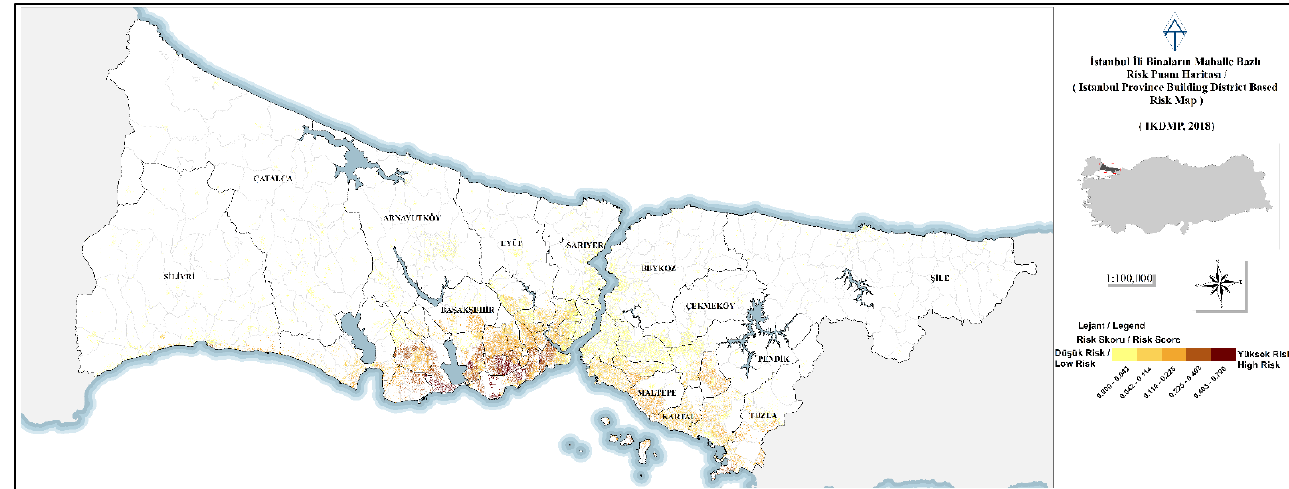
Figure 17. Istanbul Province District-Based Building Risk Score Map (IKDMP, 2018).